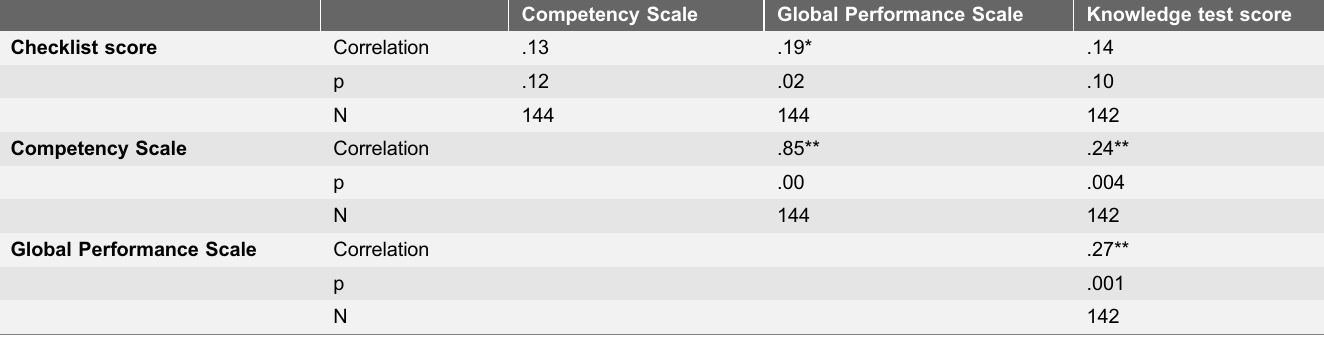
Table 4. Pearson’s Correlation coefficient between the 3 assessment formats and knowledge